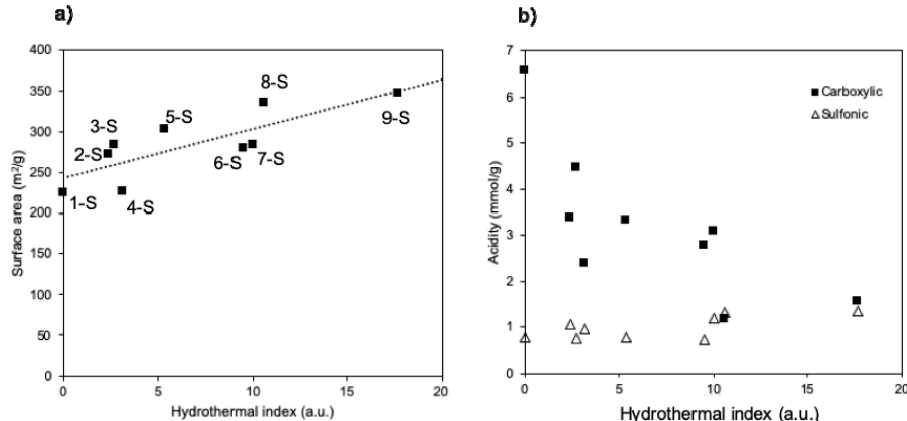
Figure 2. Relationship between hydrothermal index (H.I.) from original HTC and properties of SHTC: ( a ) Surface area; ( b ) sulfonic and carboxylic acidity (determined by difference between total acidity an sulfonic acidity).